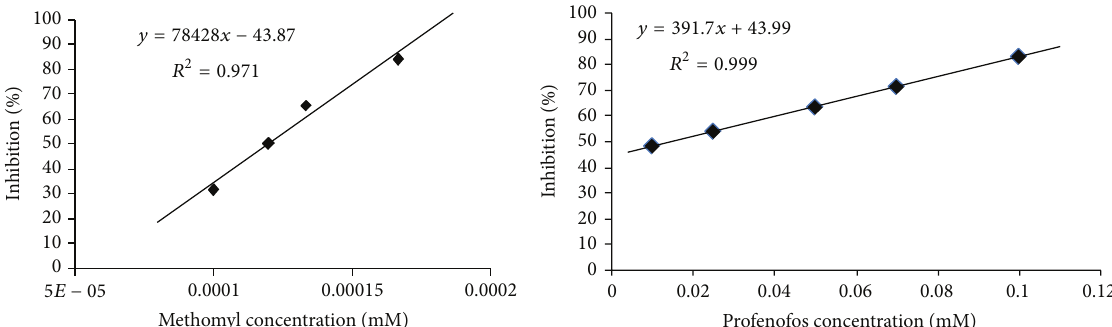
Figure 4: In vitro AChE inhibition by methomyl (carbamate) and profenofos (organophosphate) pesticides using Ellman et al. [28]